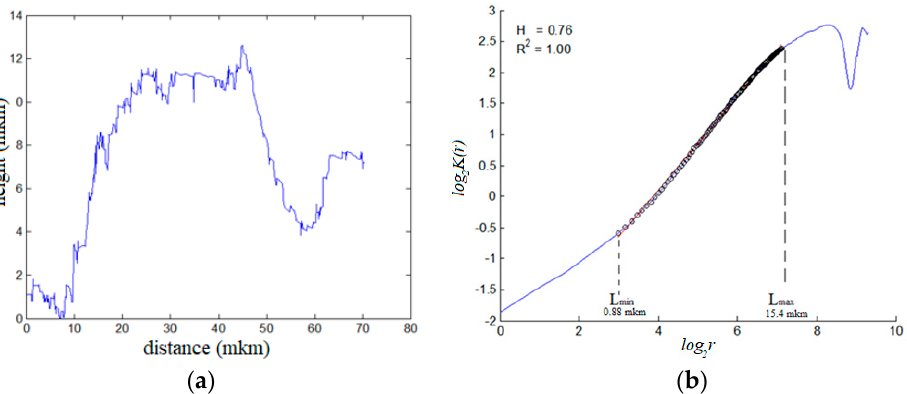
Figure 7. Characteristic for “fisheye” zone 1 of sample No. 2: ( a ) one-dimensional profile, ( b ) plot log 2 K ( r ) vs. log 2 ( r ).